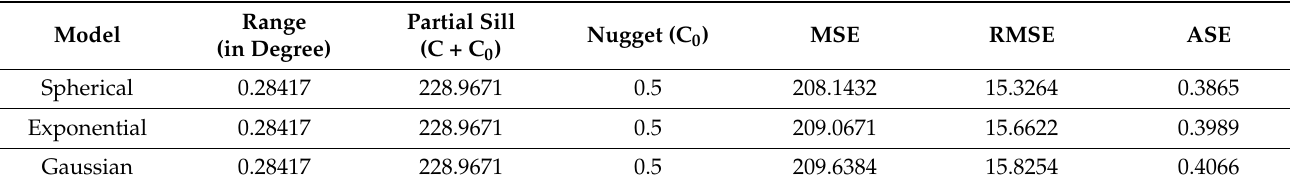
Table 3. Semivariogram experimental model parameters and cross-validation results. IK results were generated using model